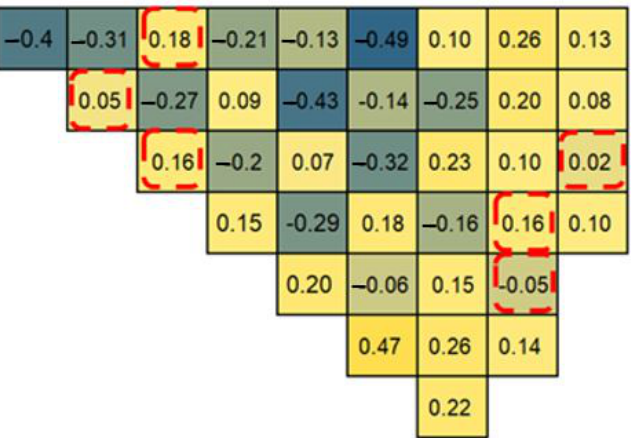
Figure 20. Corrected assembly-wise radial power distribution with P 2 scattering in HZ1 case.